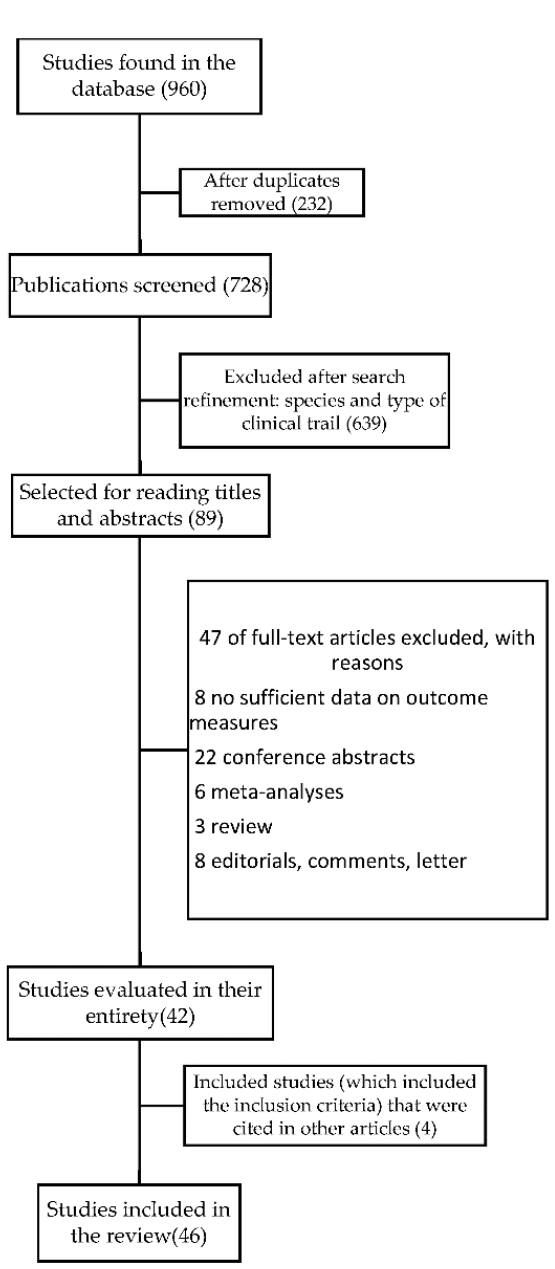
Figure 1. Steps for selecting the articles included in the review.